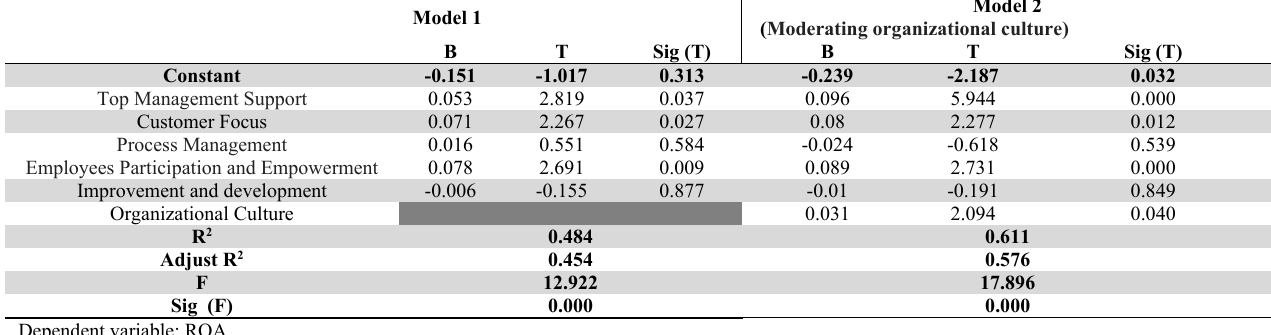
The results of testing the impact TQM on financial performance as measured by the return on